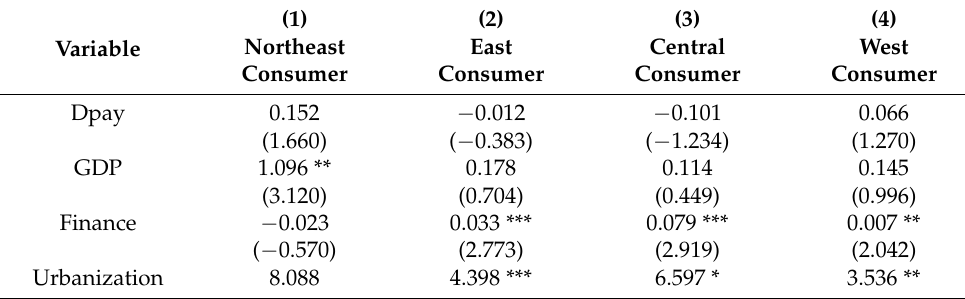
Table 13. Time heterogeneity test: